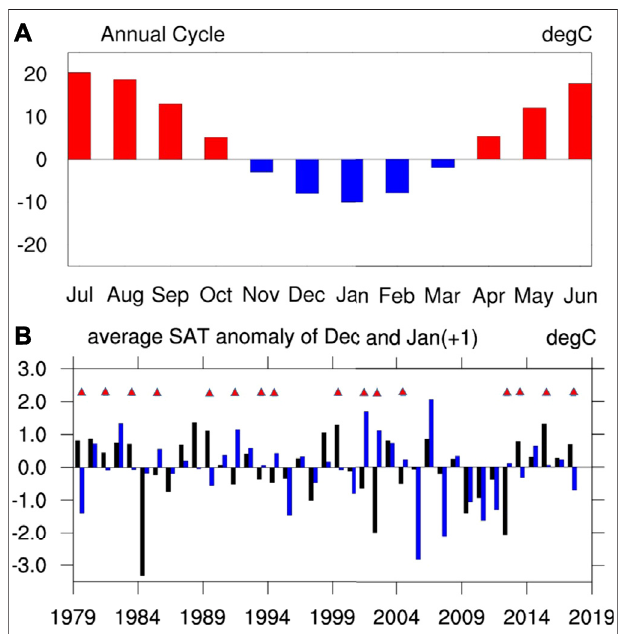
FIGURE 1 | (A) Annual cycle of monthly mean SAT of CA (35 ° – 65 ° N, 50 ° – 100 ° E) (bars; ° C) and its standard deviation (black line; ° C) during the period 1979 – 2018 (B) Anomalies of monthly mean SAT of CA ( ° C) in December (black bars) and the following January (blue bars) during the period 1979 – 2018. The red triangles represent the year in which the December and following-January SATA are of opposite